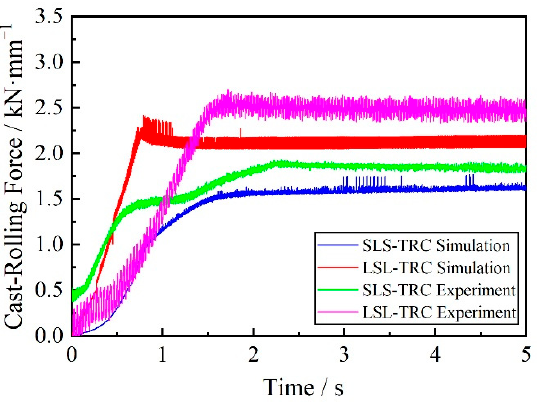
Figure 18. Cast-rolling force curves obtained from simulations and experiments of the two processes.